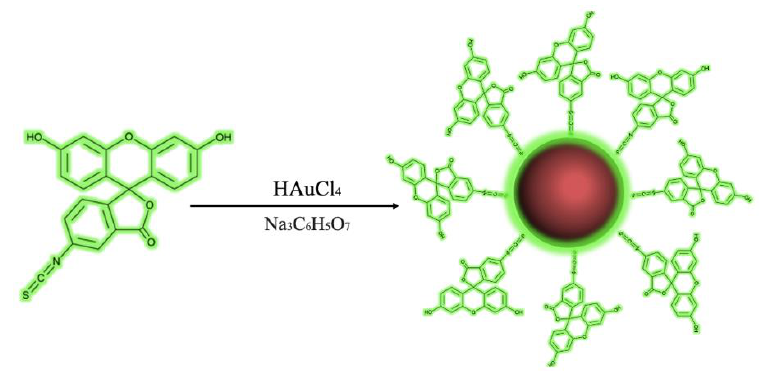
Figure 1. Representation of the addition of FI to the surface of the AuNPs in formation.